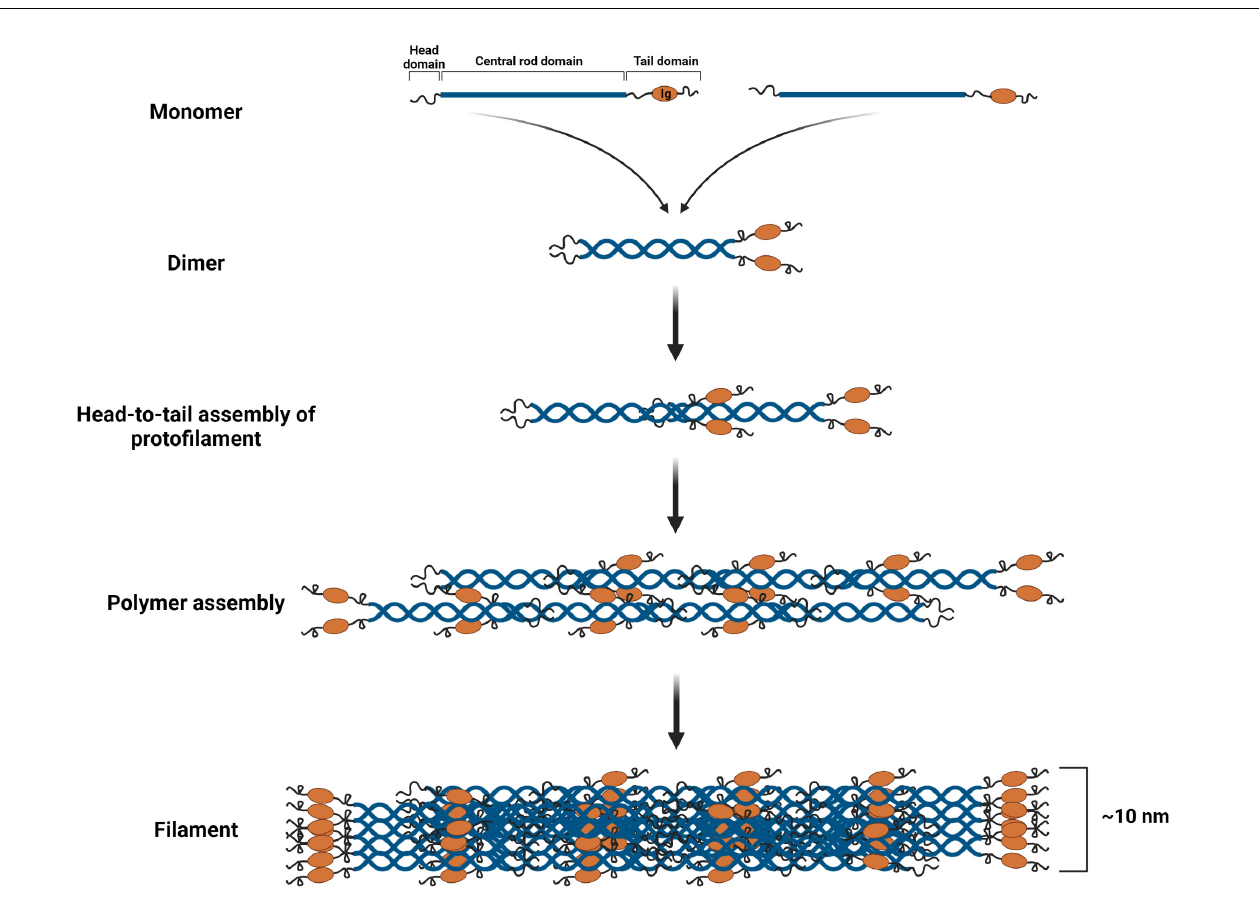
FIGURE 4 | Lamin A/C filament assembly. Lamin A/C dimers are formed from monomers that associate in a parallel, forming a coiled-coil through the central α -helical rod domain. Then lamin A/C dimers are assembled in a head-to-tail manner forming protofilament. Protofilaments through the anti-parallel association